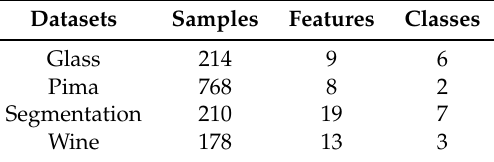
Table 2. Datasets used in the experiments.